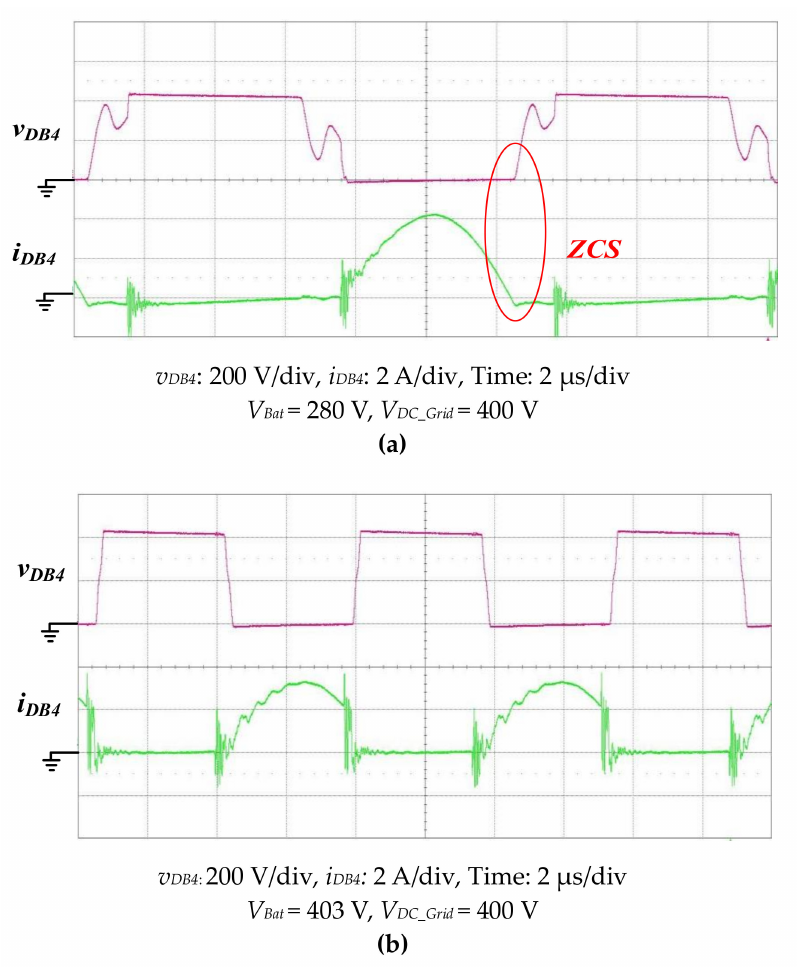
Figure 19. Waveforms of v DB4 and i DB4 with two discharging battery voltages: ( a ) V Bat = 280 V; ( b ) V Bat = 403